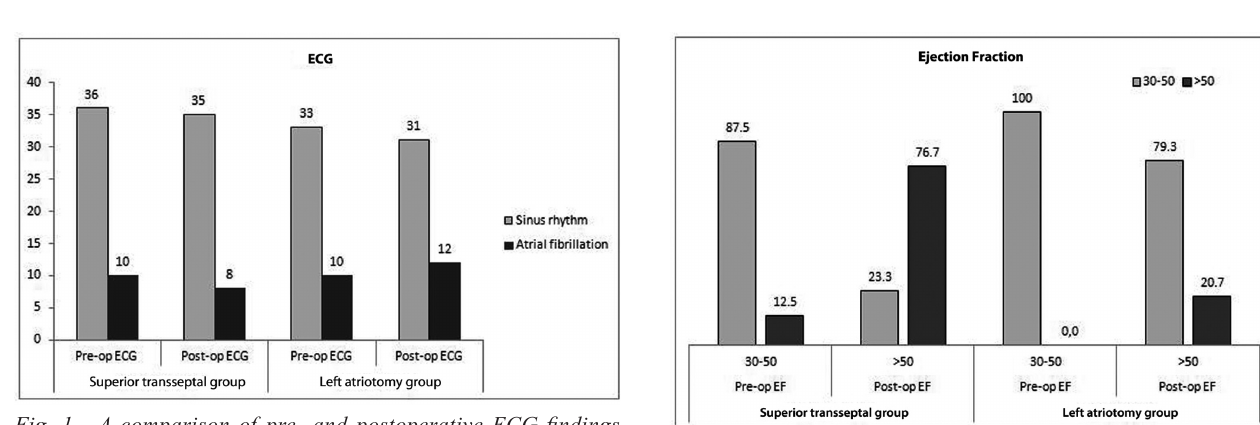
Fig. 1 - A comparison of pre- and postoperative ECG findings between the groups. Fig. 2 - A comparison of pre- and postoperative EF values between the groups.